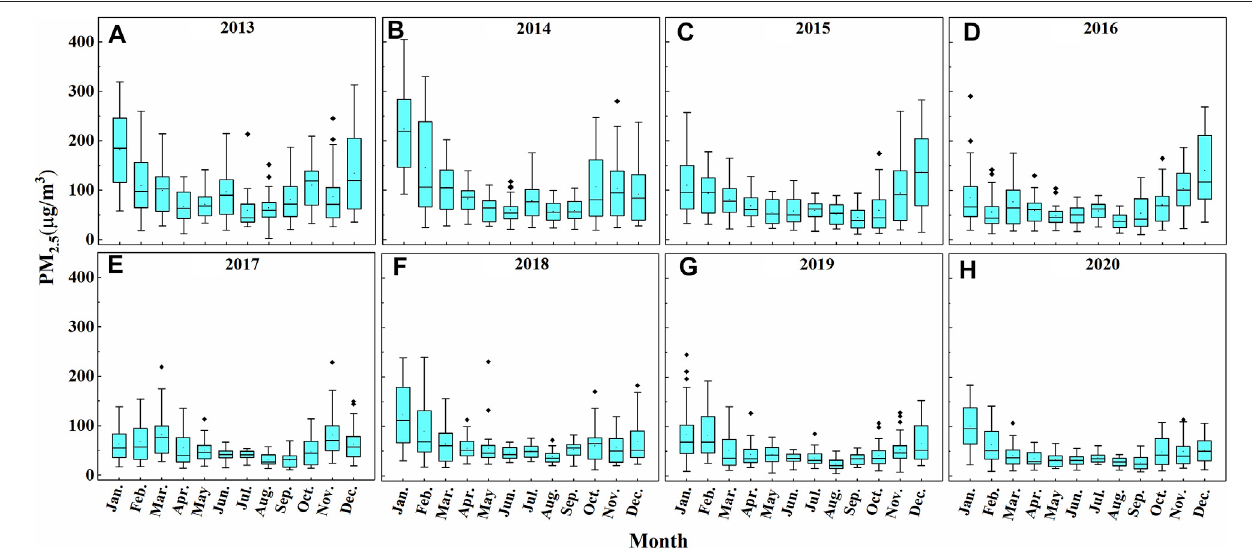
FIGURE 3 | The monthly mean observed PM 2.5 concentrations from 2013 to 2020 (A – H) in the Beijing – Tianjin – Hebei region.